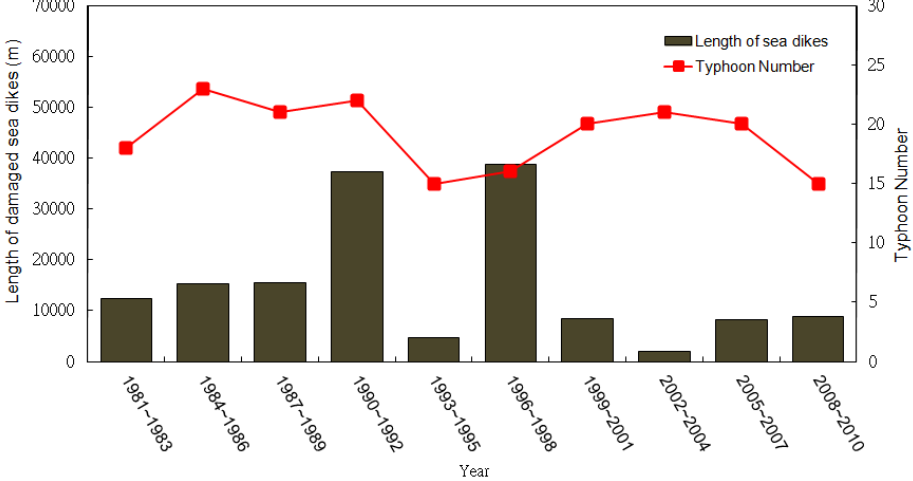
Figure 2 Statistics of the damaged sea dyke from 1981 to 2010 Fig. 2. Statistics of the damaged sea dyke from 1981 to